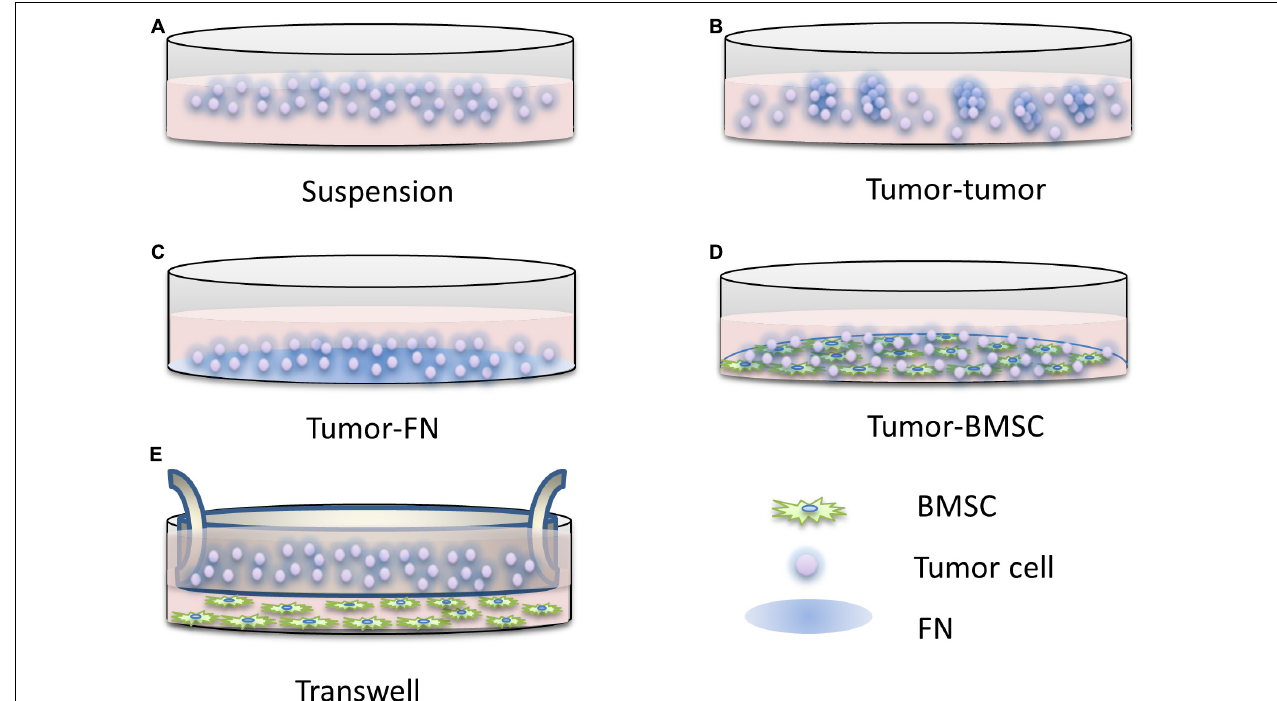
FIGURE 2 | The research pattern diagram of CAM-DR. Construction of CAM-DR model in vitro through the construction of FN adhesion model (C) and cell–cell direct adhesion model (D) , transwell model (E) can be used to study the relationship of directly acting soluble factors between cells, organ-like culture model (B) is relatively less used, and simple suspension culture model (A) is used as